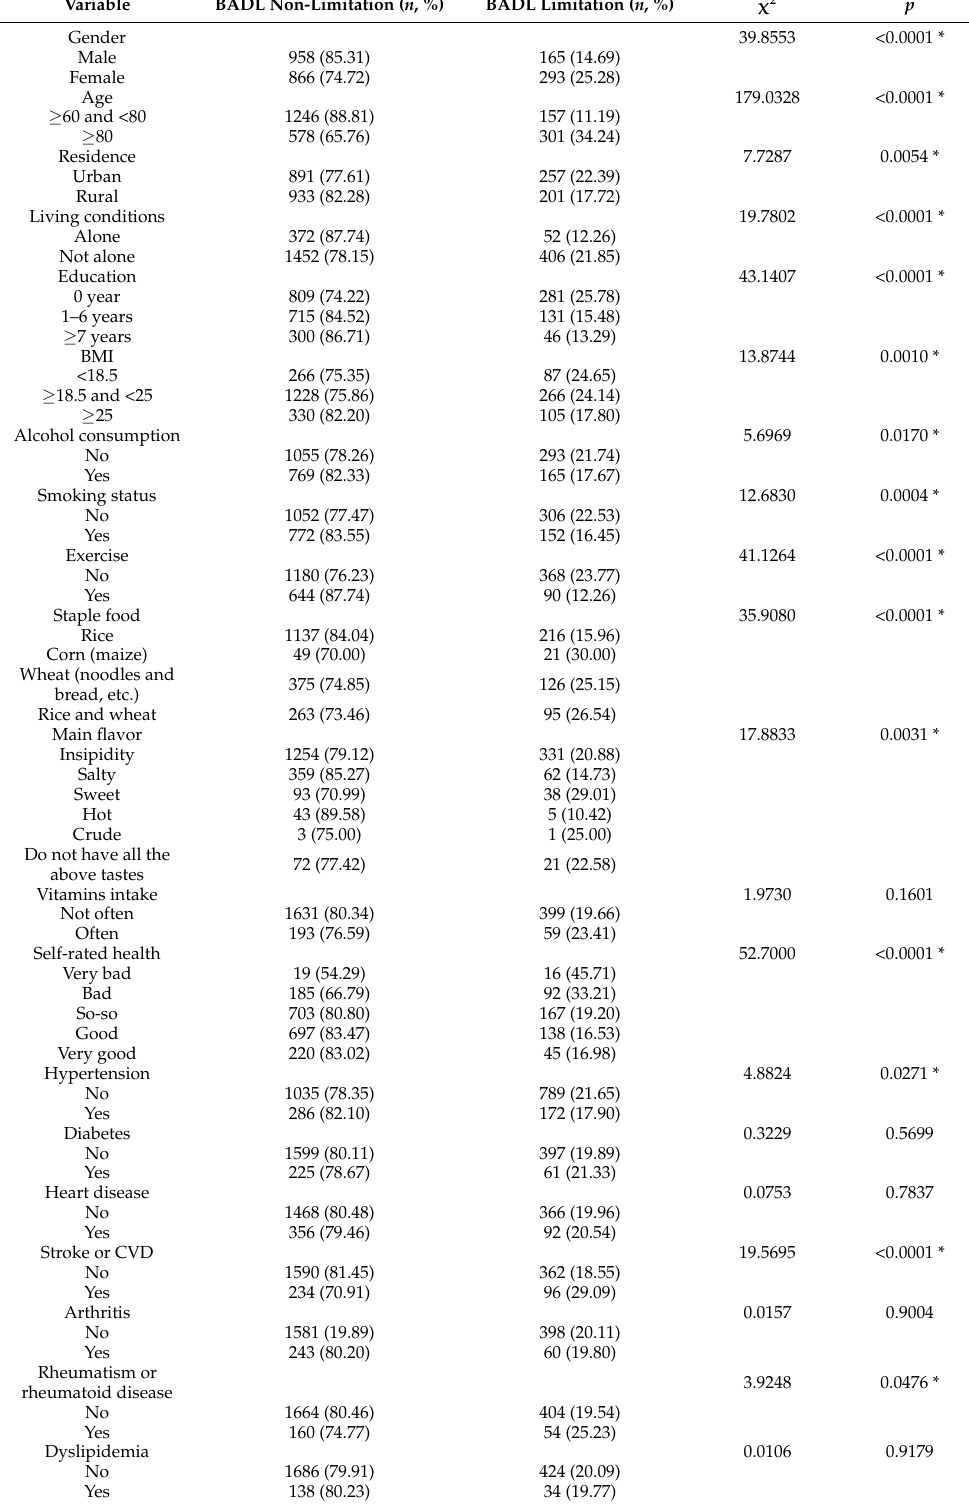
Table 1. Baseline characteristics of BADL non-limitation group and BADL limitation group ( n = 2282).